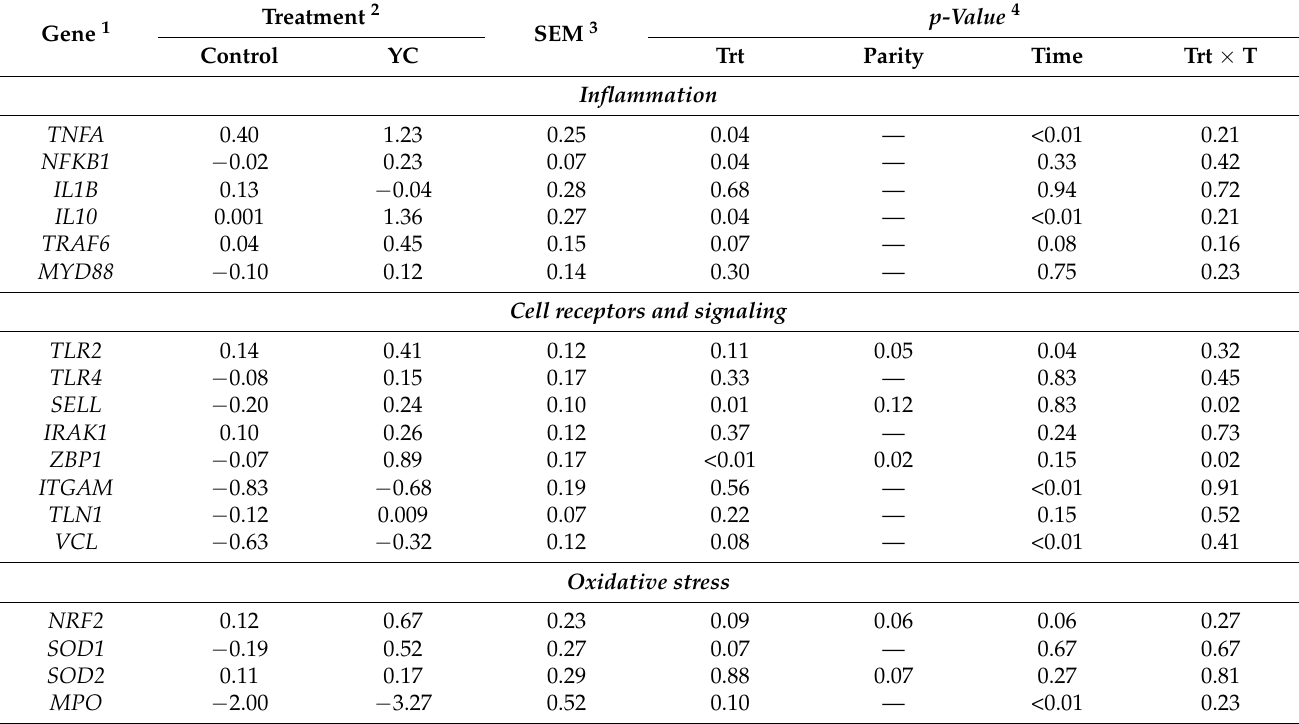
Table 2. Polymorphonuclear leukocyte gene expression of target genes related to inflammation, cell receptors and signaling, and oxidative stress in dairy cows fed a basal diet (Control) or a basal